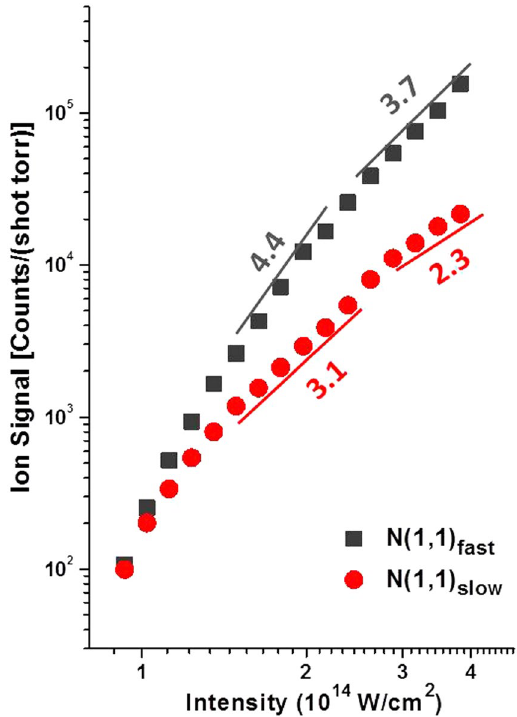
Figure 4. Fitting with the exponential order of the ion yield curves for N(1,1) fast and N(1,1) slow at the intensity corresponding to 2 I 0 and 4 I 0 , where I 0 = 10 14 W/cm 2